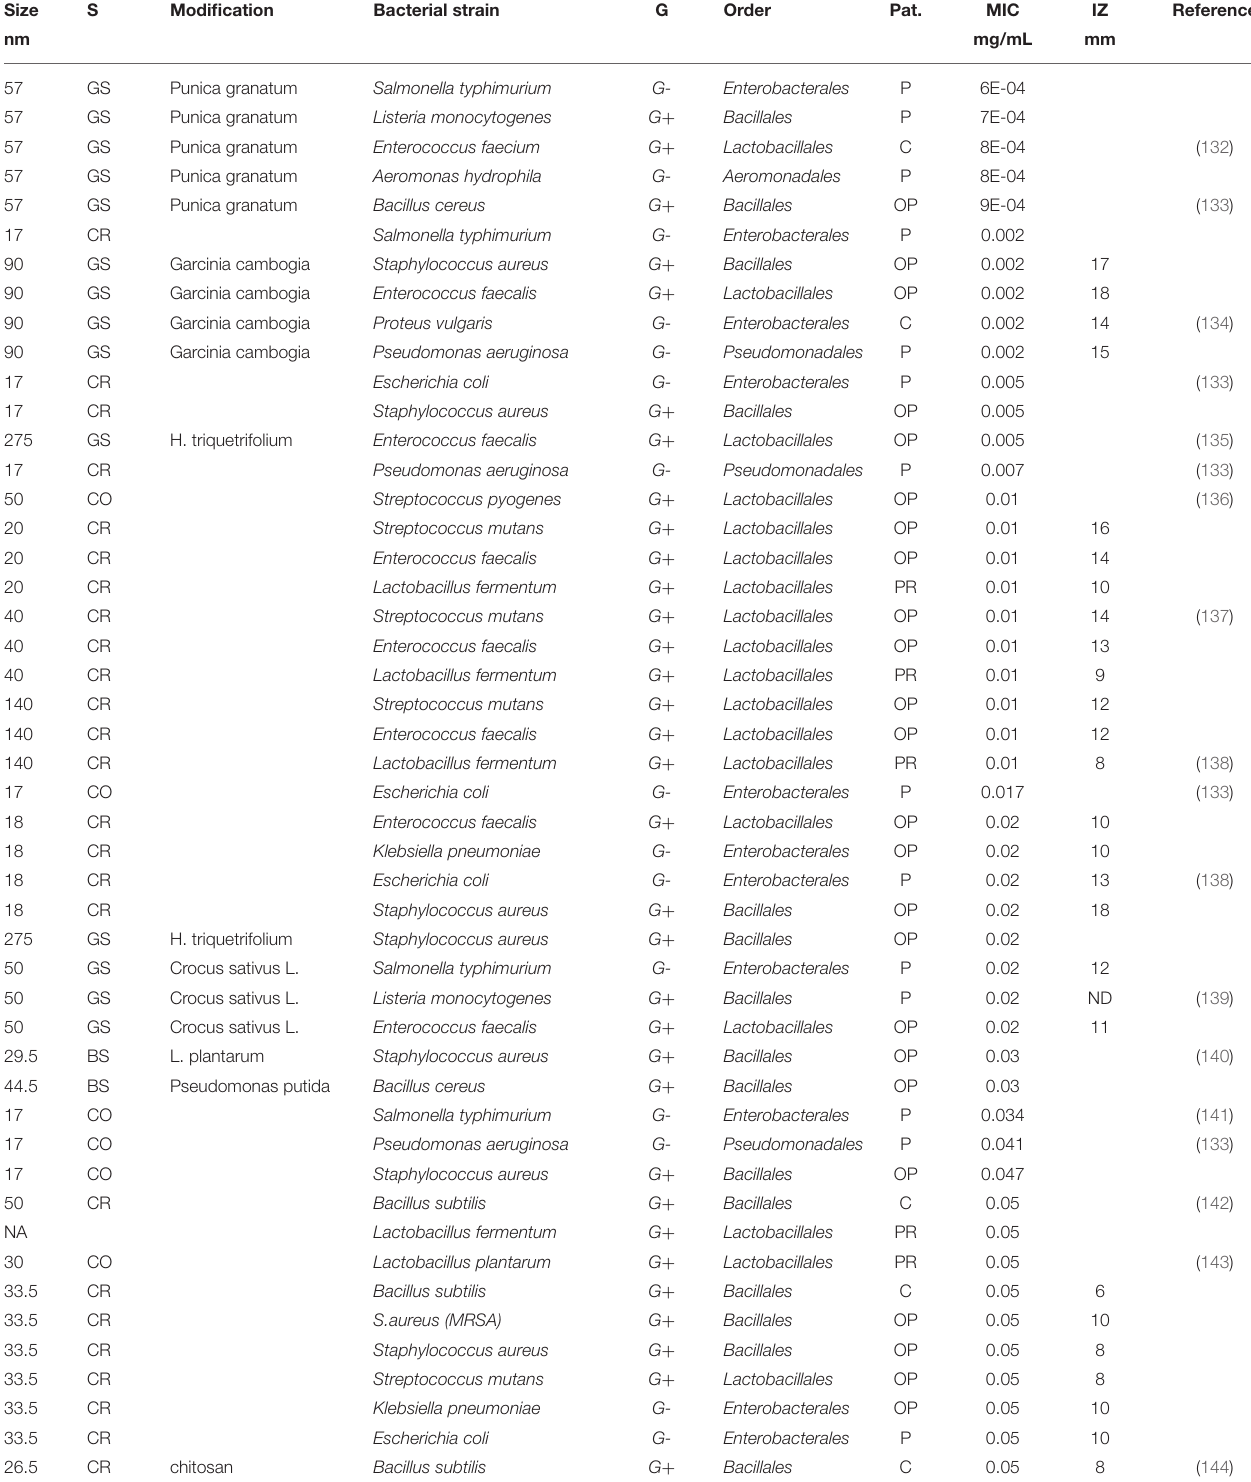
TABLE 2 | Antimicrobial effect of ZnO nanoparticles tested in vitro .